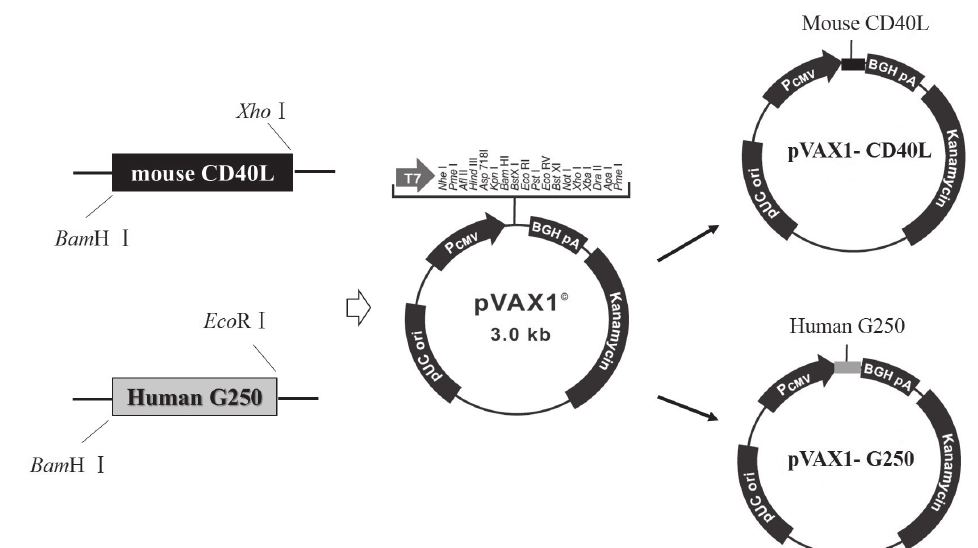
FIGURE 1 - Construction of the recombinant plasmids harboring the genes encoding G250 and